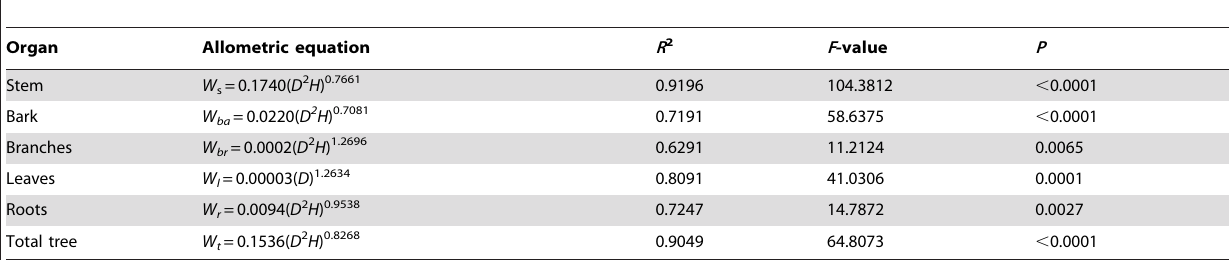
Table 4. Individual biomass regressions models for Mytilaria laosensis trees ( n =18 for all models); W , biomass; D , DBH; H , height.